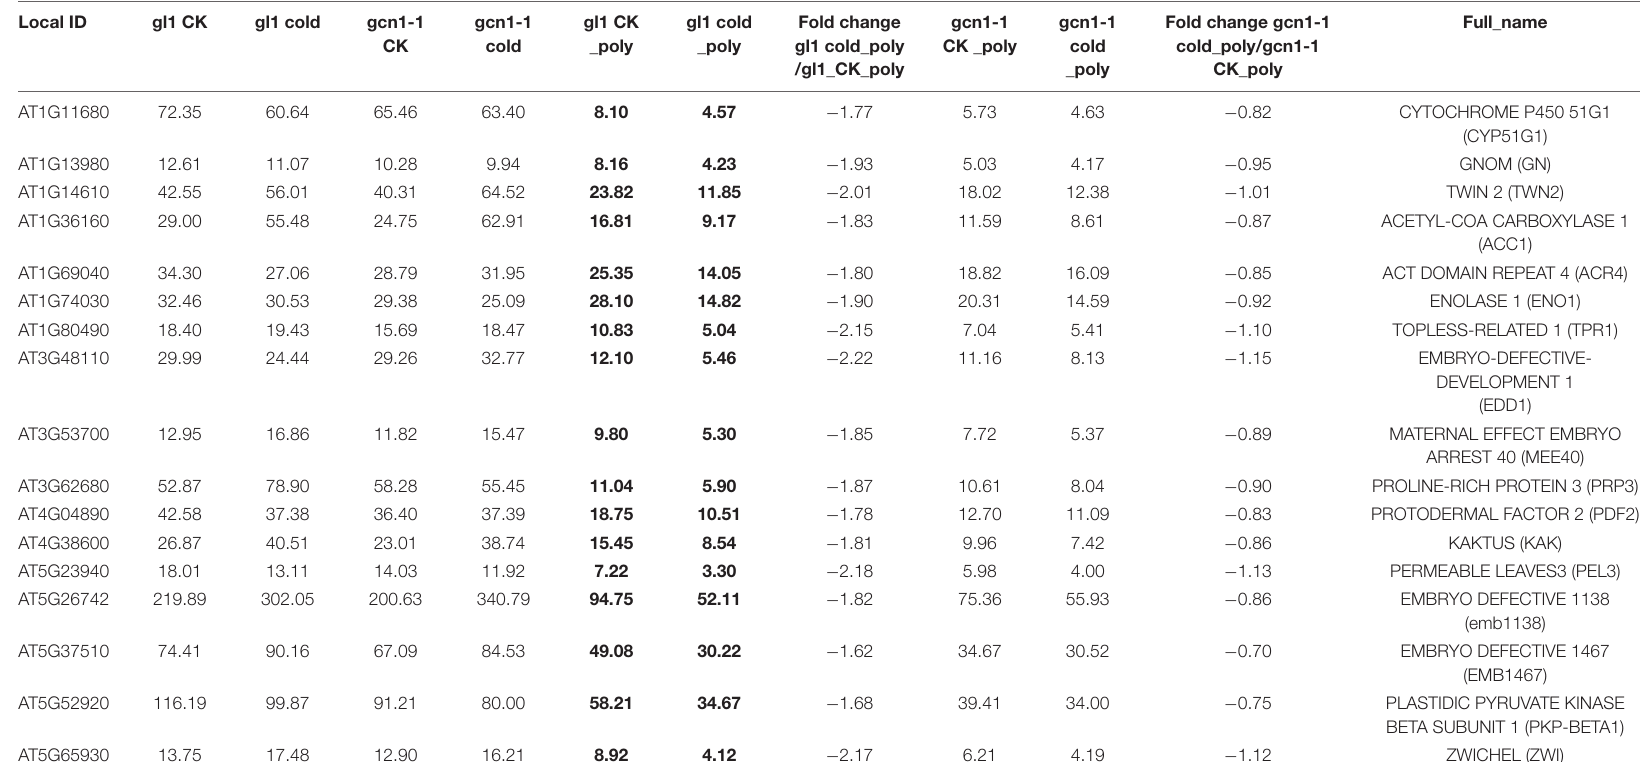
TABLE 3 | Cold-ATGCN1 down-translated genes are involved in embryonic development ending in seed dormancy and seed development. Local ID